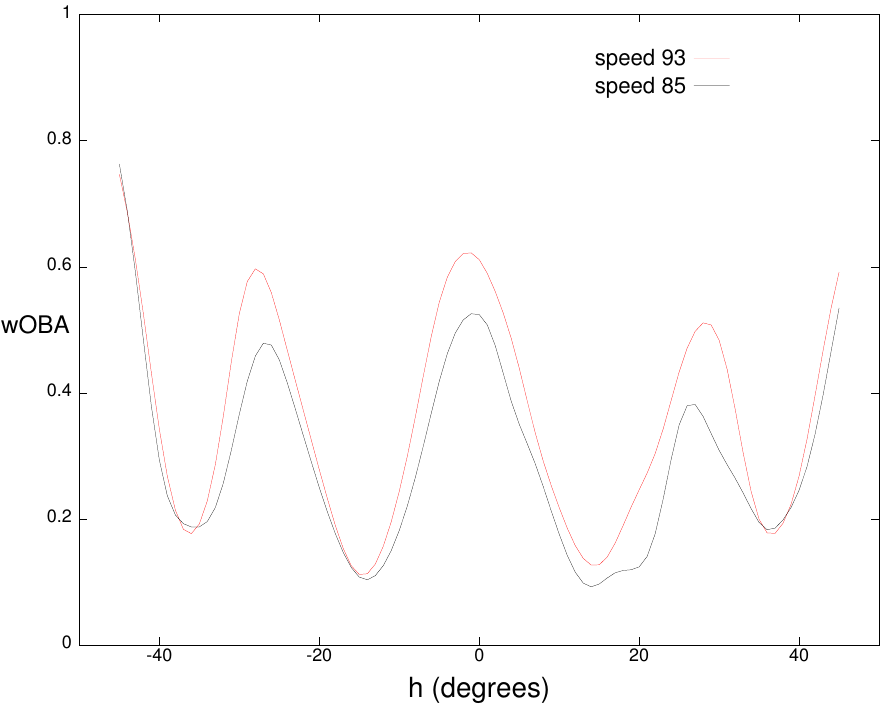
Figure 3. Weighted on base average (wOBA) for a batted ball with a vertical angle v of − 5 ◦ for speed s of 85 miles per hour and 93 miles per